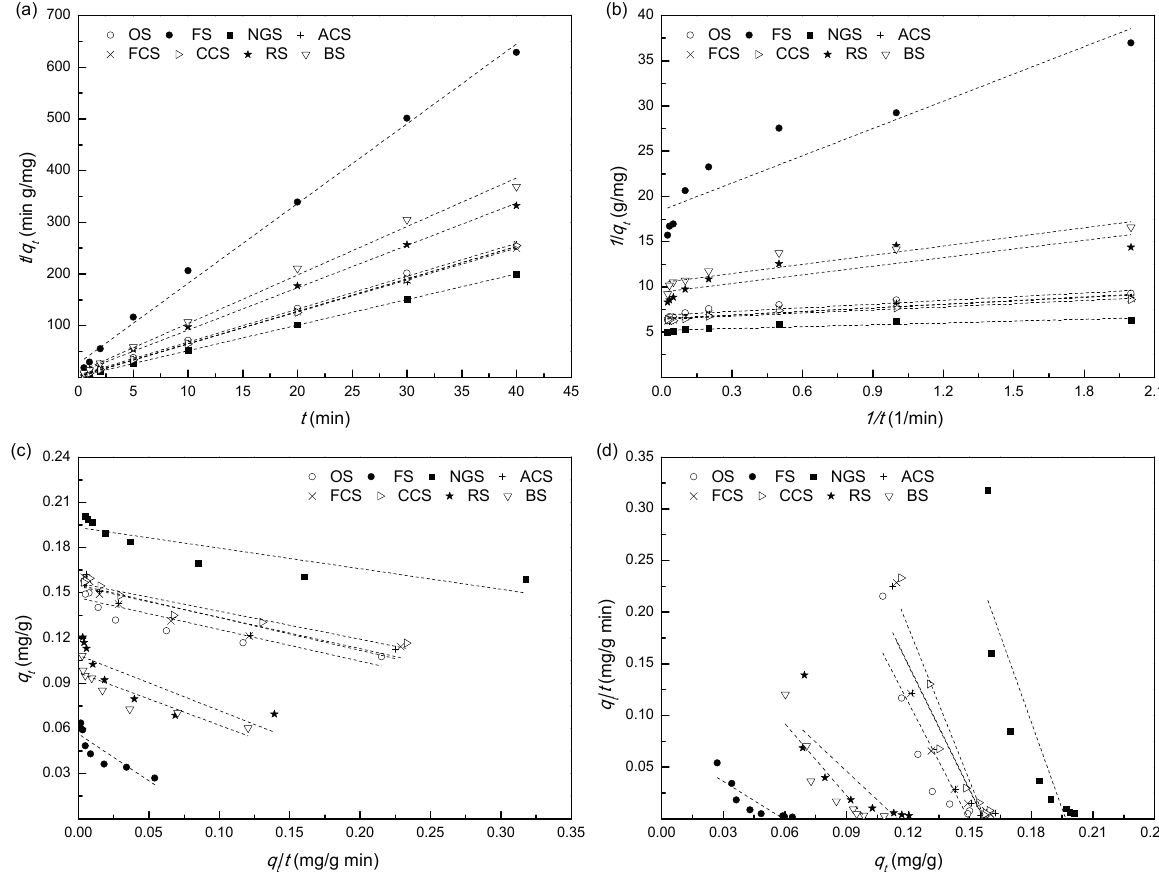
Figure 3. Pseudo-second-order kinetic plots for four types of linear equations ( a – d )